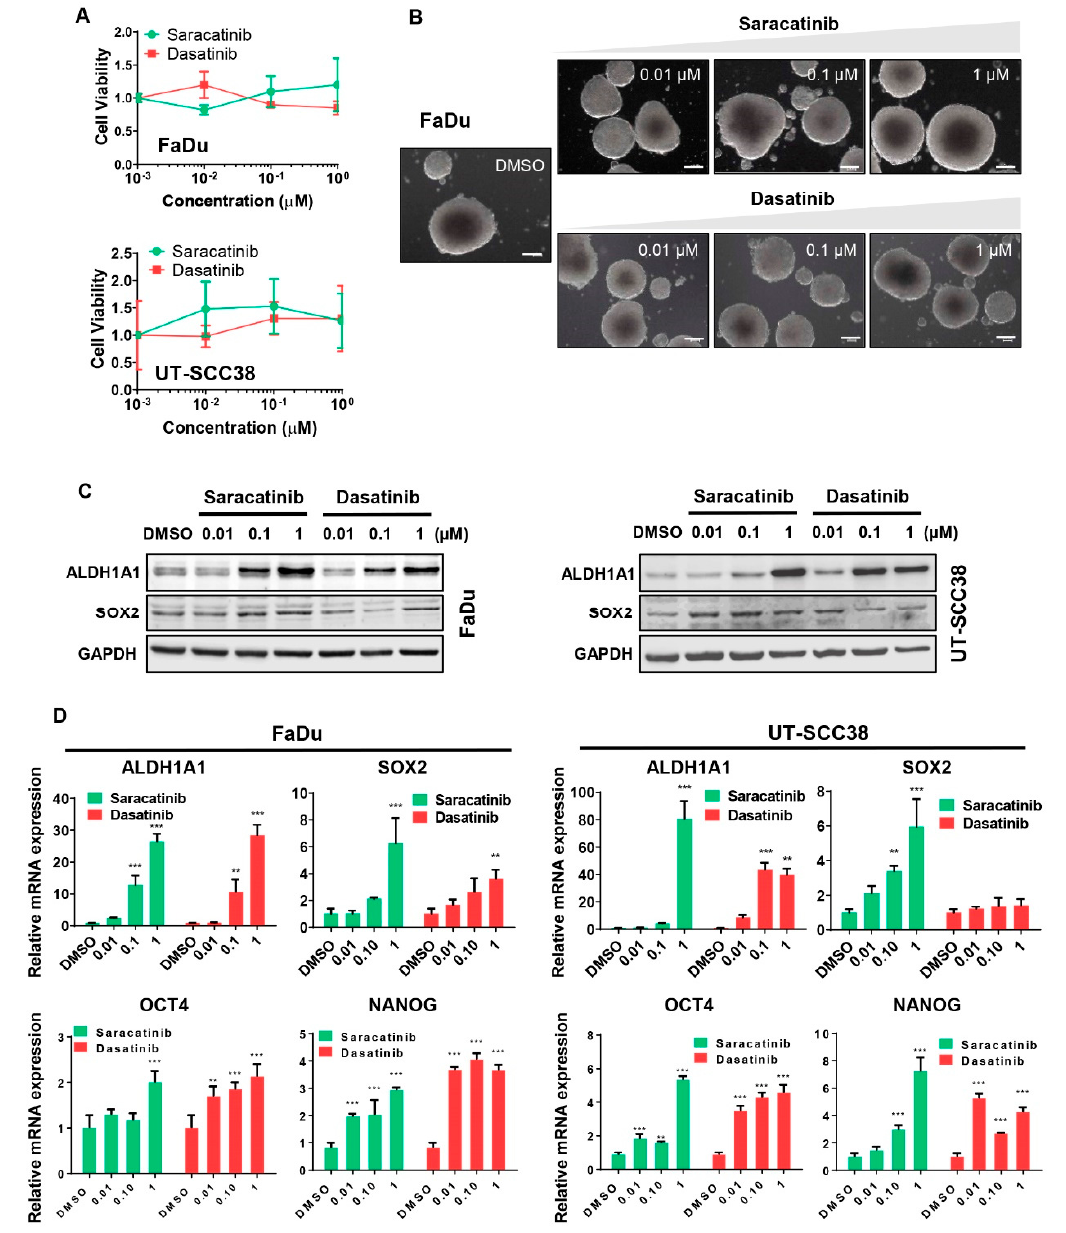
Figure 2. E ff ect of dasatinib and saracatinib on the cancer stem cells (CSC) properties of HNSCC-derived cell lines. ( A , B ) Cell viability (MTS assay) of UT-SCC38 and FaDu tumorspheres treated with increasing concentrations of dasatinib or saracatinib for 72 h. Quantification of cell viability ( A ) and representative images of FaDu tumorspheres upon the indicated treatments ( B ) are shown. ( C , D ) Analysis of the protein (Western blotting; C and quantification of IRdye fluorescent signals are plotted in Supplementary Figure S3A) and relative mRNA (RT-qPCR); ( D ) levels of the CSC-markers ALDH1A1, SOX2, OCT4, and NANOG in FaDu and UT-SCC38 cells treated with increasing concentrations of dasatinib and saracatinib for 72 h. Data were normalized to RPL19 levels and represented relative to vehicle-treated cells (mean ± SD, Student’s t -test, ** p < 0.01, *** p < 0.001).